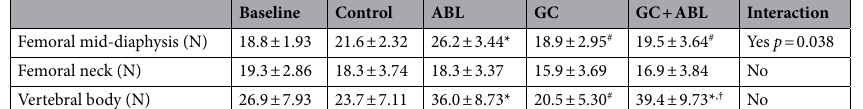
Table 5. Bone strength of the femoral mid-diaphysis, femoral neck, and vertebral body of L4 of mice subjected to subcutaneous slow-release glucocorticoid (GC) pellets and treated with abaloparatide (ABL) for four weeks. Mean ± SD. * p < 0.05 vs. Control. # p < 0.05 vs. ABL. † p < 0.05 vs.